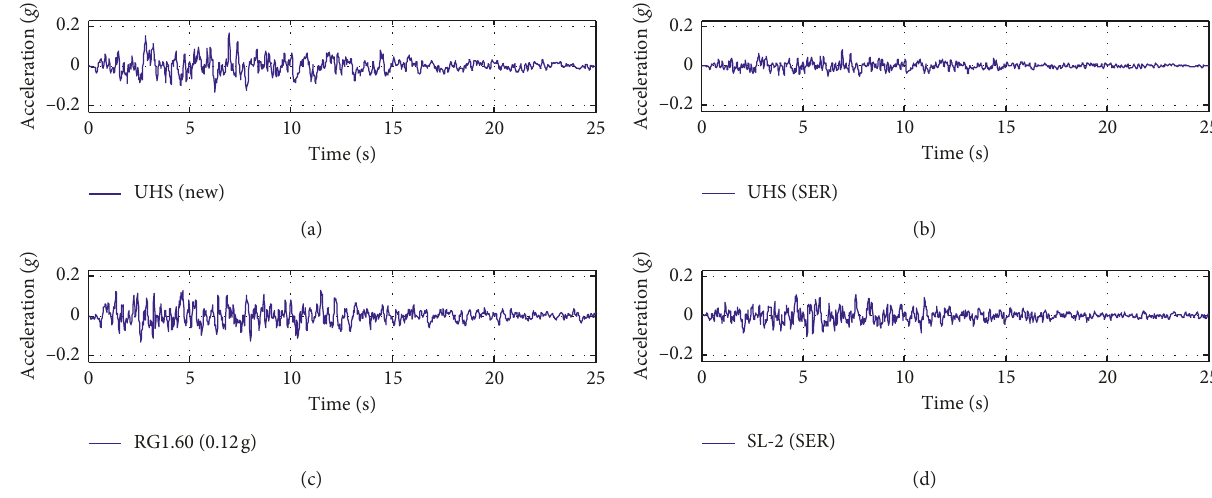
Figure 12: Acceleration time-history curve in the X direction. Each response generated two artificial seismic waves; the number of cross- correlation coefficients was less than 0.3.